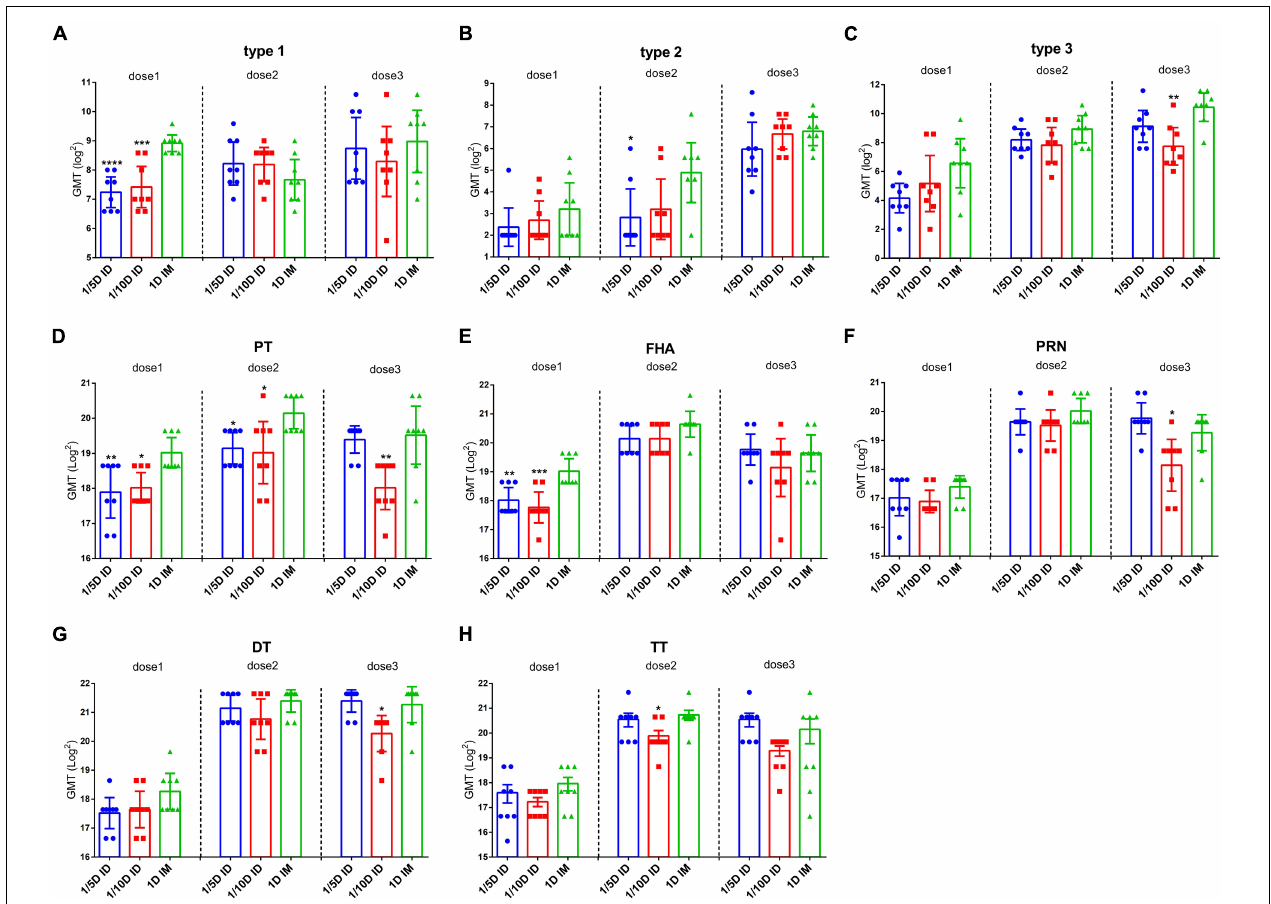
FIGURE 2 | Intradermal immunization induced the same antibody levels as the full-dose of the intramuscular immunization did. ELISAs were used to compare serological responses from rats immunized through 1/5 or 1/10 dose ID to 1 dose IM rats ( n = 8). Virus neutralizing antibody titers from rats at 28 days after every dose of immunization (A) type 1 (B) type 2 and (C) type 3, respectively. The results were shown as the log2 of virus neutralizing titers of the geometric mean ± 95% CI. Total IgG serum antibody were quantified against (D) PT, (E) FHA, (F) PRN, (G) DT and (H) TT at 28 days after each dose of immunization. The results were shown as the log2 of antibody titers of the geometric mean ± 95% CI. The PBS group results are below the detection limit and were not shown in figure. Data were analyzed using an one-way ANOVA model with Tukey’s multiple comparisons test. * P < 0.05, ** P < 0.01, *** P < 0.001, and **** P < 0.0001 vs 1D IM group ( n = 8).